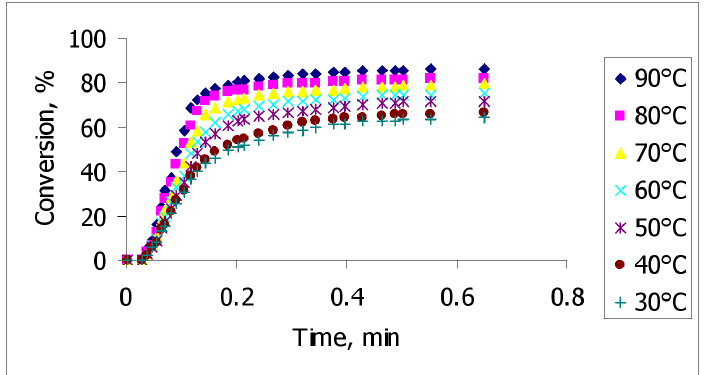
Fig. 6 Conversion versus time of exposure for temperature range 30-90 ◦ C (photopolymerizable system: monomer EDA, photoinitiator MBDPPO 3 % (w/w) and triehtylamine as additive 3 %